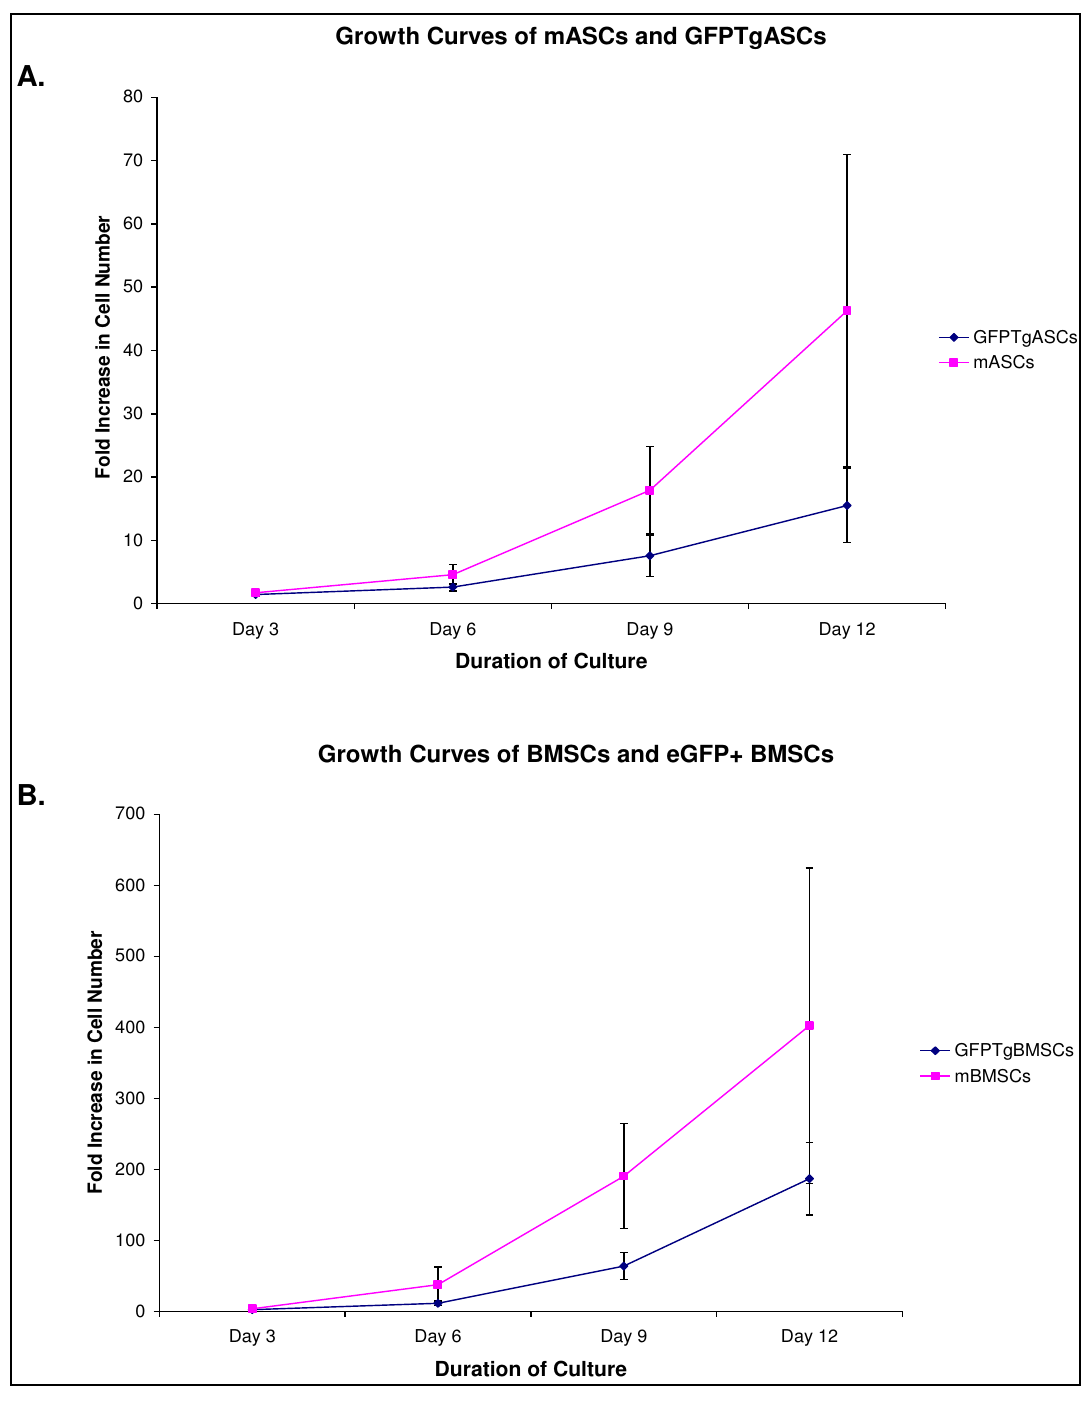
Figure 5 A. Growth Curves of mASCs and GFPTgASCs . Cells were plated at an original density of 100 cells/cm 2 and cultured for 12 days. The difference in growth rate between mASCs and GFPTgASCs is not statistically significant (p > 0.05). B. Growth Curves of mBMSCs and GFPTgBMSCs. Cells were plated at an original density of 100 cells/cm 2 and cultured for 12 days. The difference in growth rate between mBMSCs and GFPTgBMSCs is not statistically significant (p >